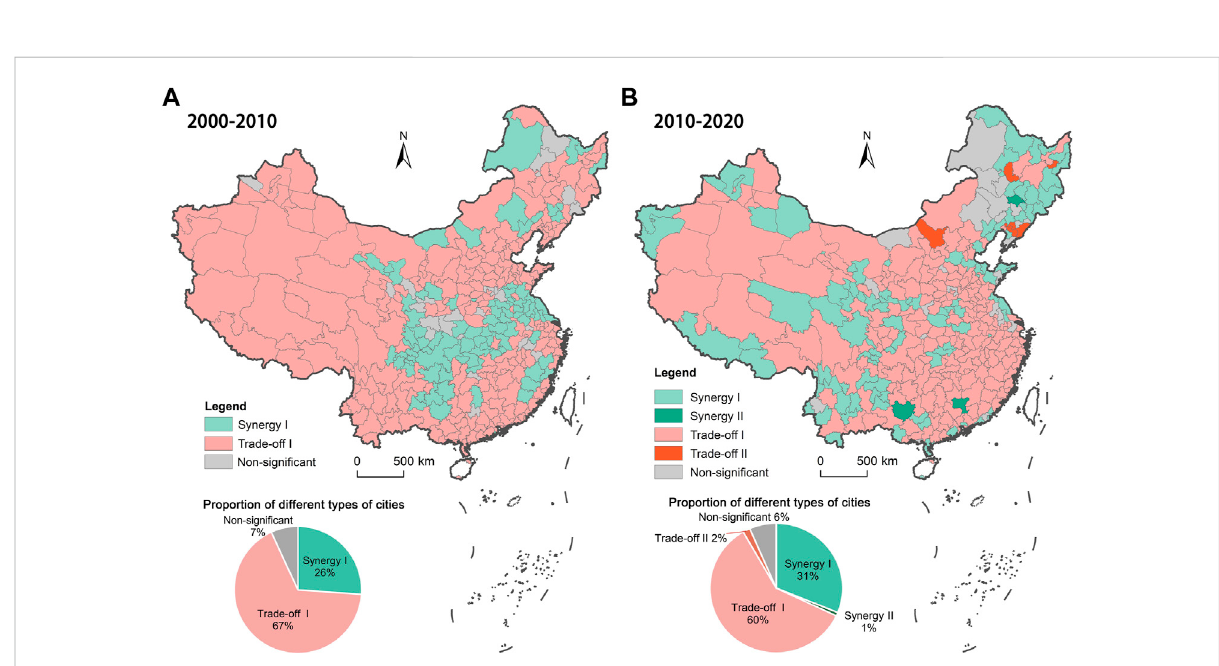
FIGURE 8 Trade-offs and synergies between ecosystem services and human